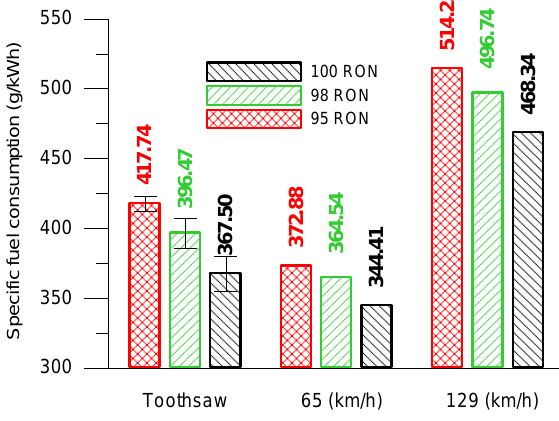
Figure 7. Average specific fuel consumption along toothsaw and steady-state modes.